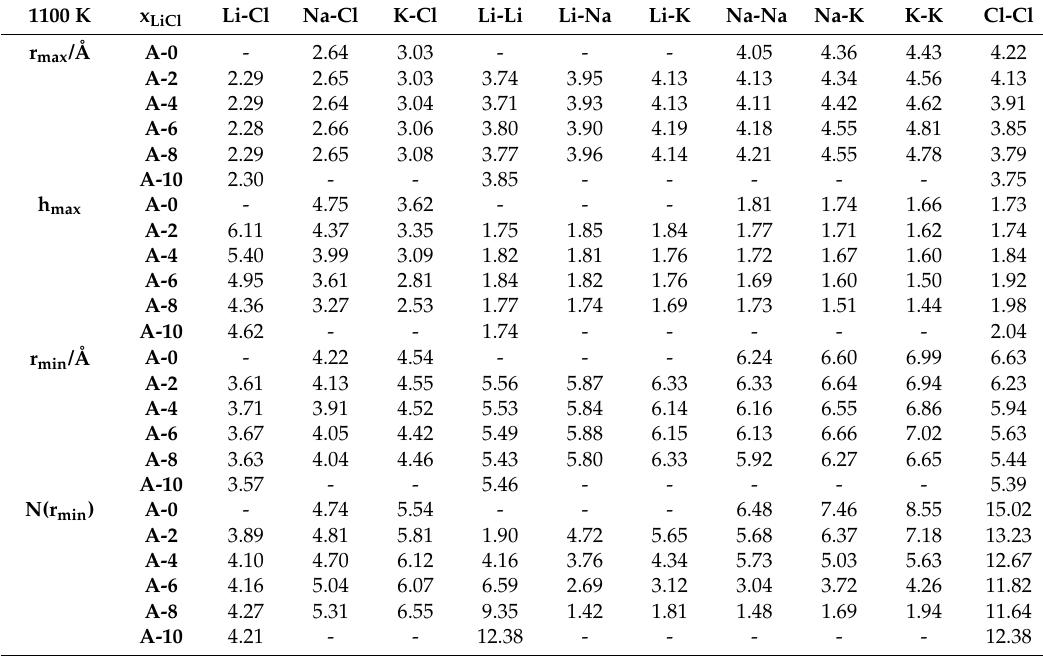
Figure 2. PDFs of four ternary systems (A-2, A-4, A-6, A-8) at 1100 K. Table 3. Structural parameters for six typical ternary systems at 1100 K.